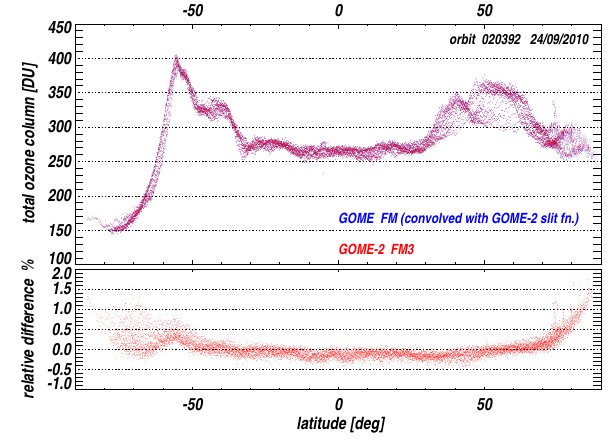
Fig. 6. GOME-2 ozone fit residuals (RMS) as a function of applied wavelength to the GOME-2 FM3 cross sections. Minimum RMS is obtained at − 0.038nm.